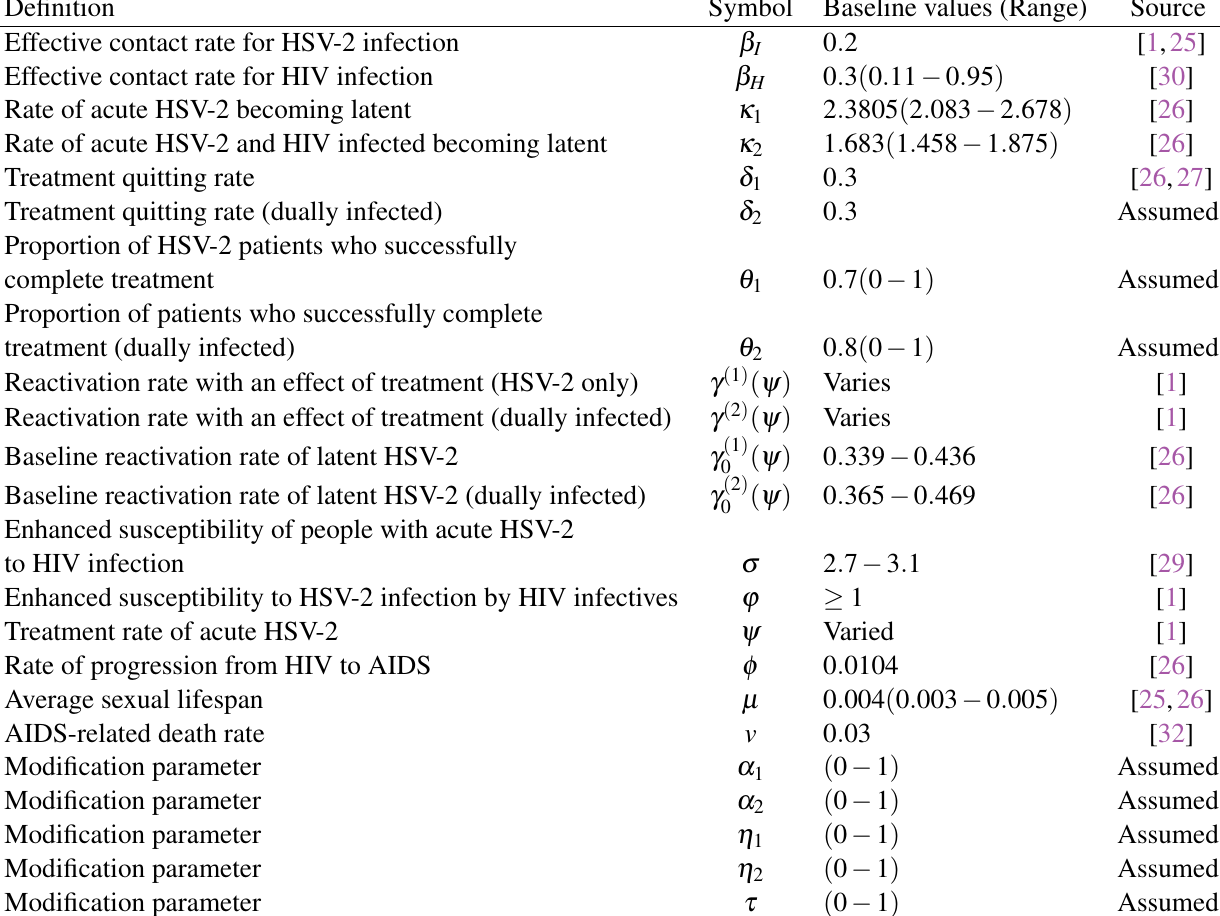
Table 1 Model parameters and their baseline values. The time unit is in